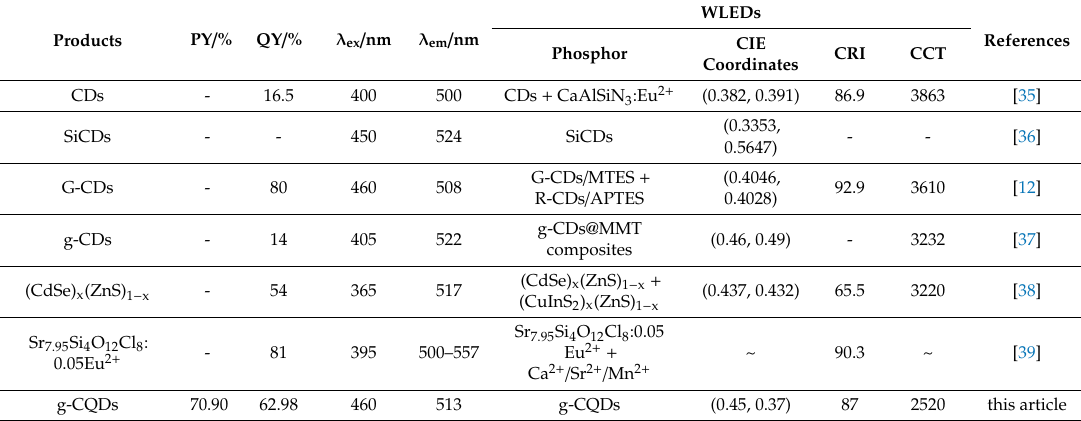
Table 5. Comparison of LEDs fabricated by the blue chip and di ff erent g-CQDs and other